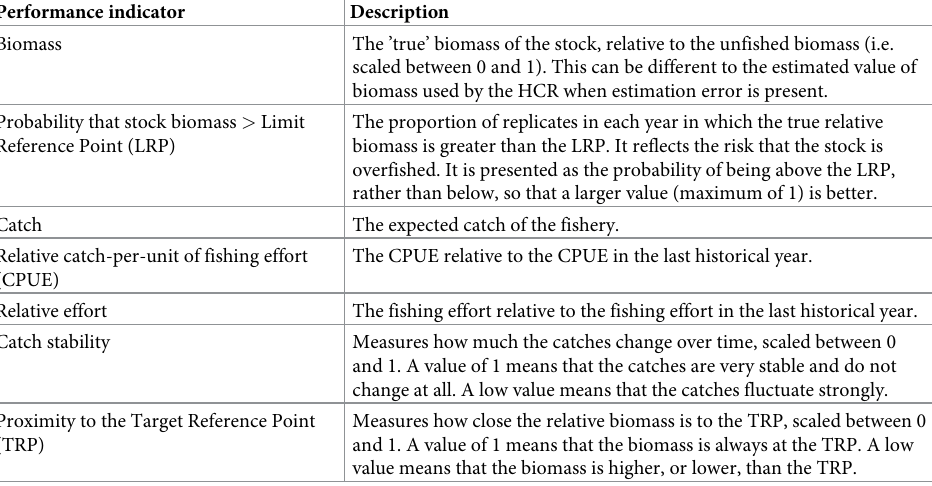
Table 1. Performance indicators calculated for the measuring performance and comparing performance